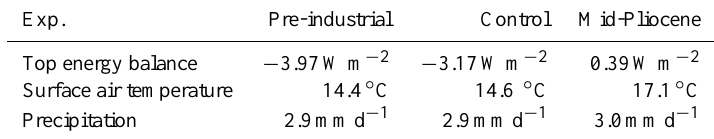
Vegetation Local pre-industrial Local pre-industrial PRISM vegetation Orbital parameters Year 1950 Year 1950 Year 1950 Table 2. Globally averaged climatology for the pre-industrial, the control and the mid-Pliocene experiment Exp. Pre-industrial